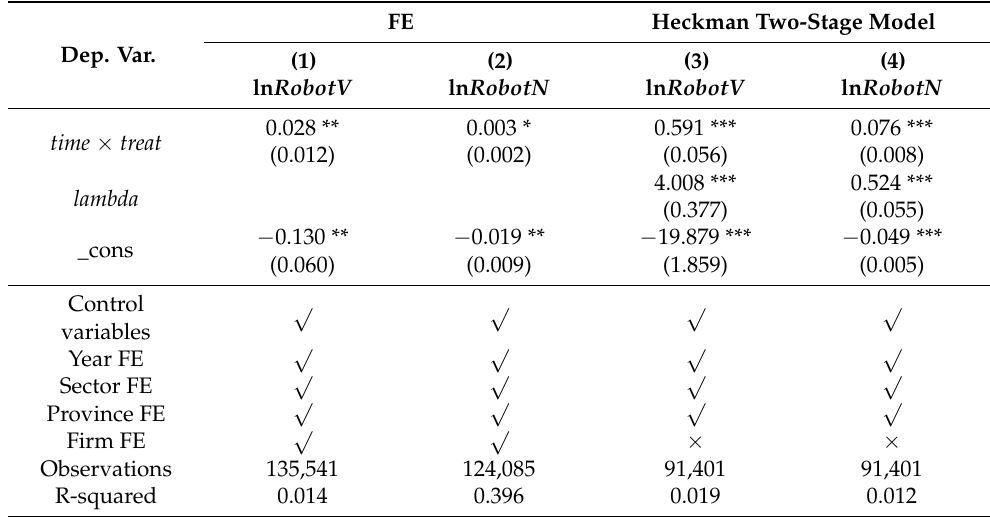
Table 13. Impact of the SO 2 ETS on robot application.